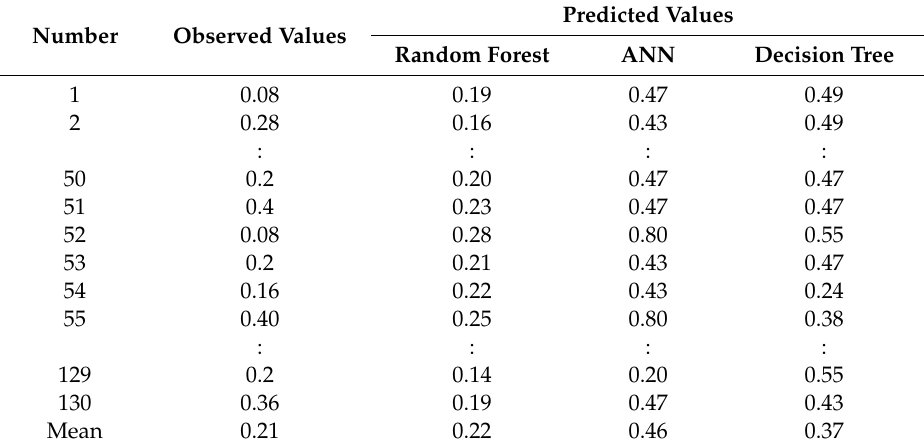
Table 2. Predicted accident level (AL) values obtained from three models.